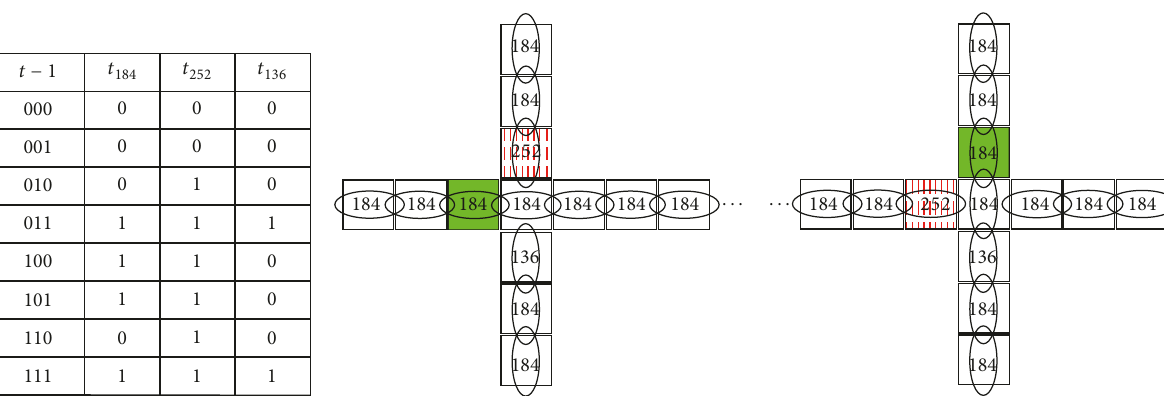
Figure 3: Set of rules applied in the ECA city model (184, 252, and 136) and the configuration of rules around an intersection [13].